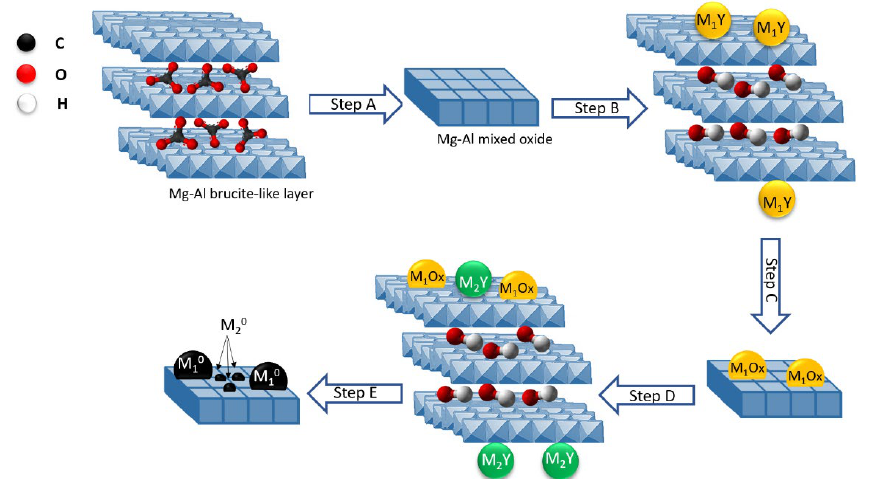
Figure 8. Synthetic strategy of preparing bimetallic catalysts, supported on Mg–Al mixed oxide: calcination of synthetic hydrotalcite in air at 500 °C to Mg(Al)O mixed oxide (step A), introduction of a transition metal M 1 as an anionic chelate (M 1 Y − ) using a ‘‘memory effect’’ of calcined HT (step B), second calcination in air at 500 °C (step C), reconstruction of a layered structure and introduction of a second metal M 2 , i.e., Ru(III) pre-chelated with EDTA (step D), and an in situ generation of a bimetallic (M 2 -M 1 ) catalyst from LDH precursor under the DRM reaction conditions (step E). Reprinted with permission from [186], copyright 2005, Elsevier.